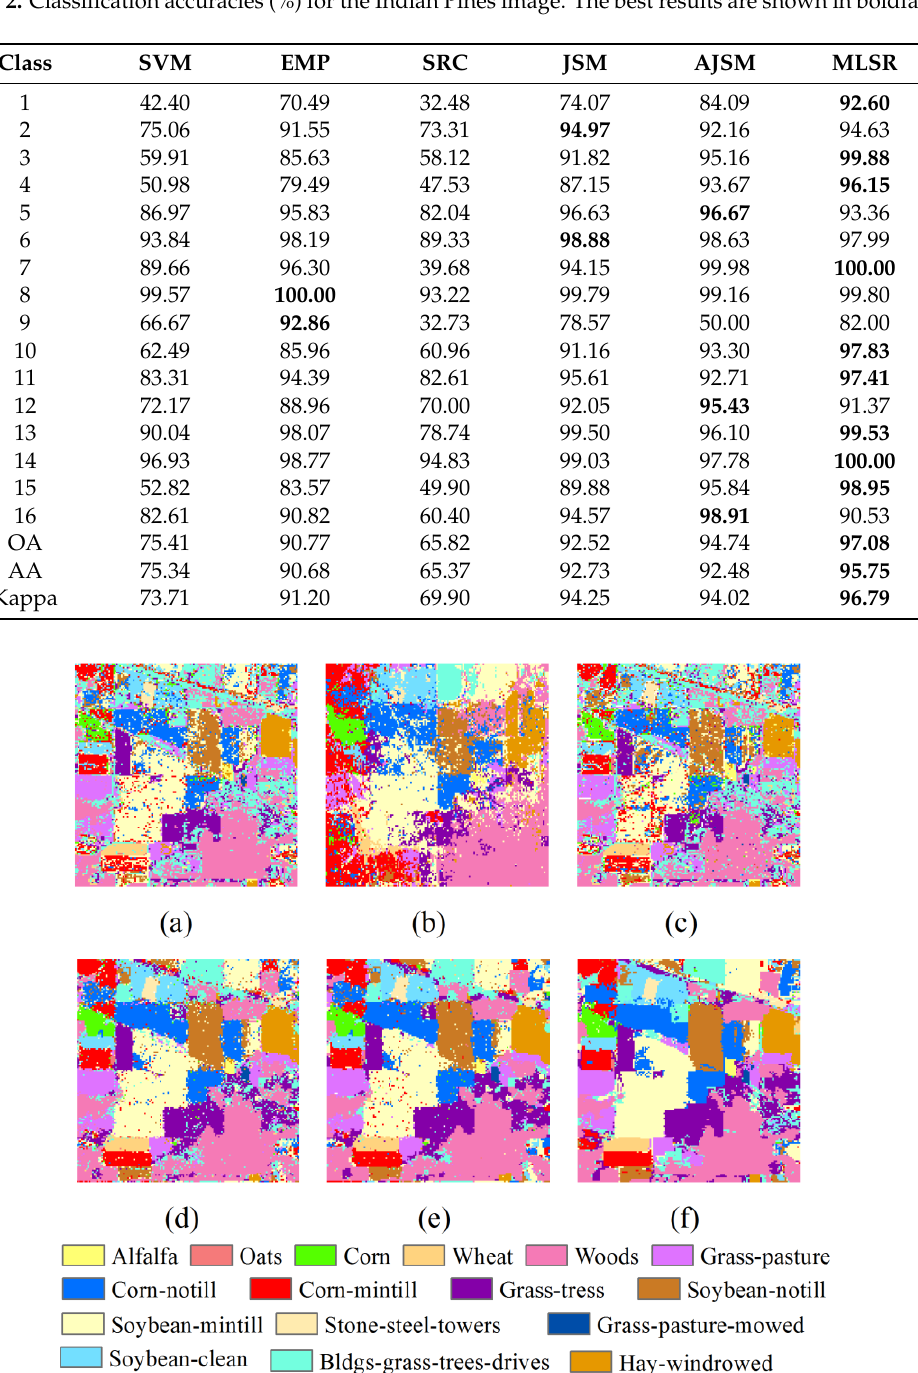
Figure 3. Classification maps of Indian Pines: ( a ) SVM; ( b ) EMP; ( c ) SRC; ( d ) JSM; ( e ) AJSM; and ( f ) MLSR.